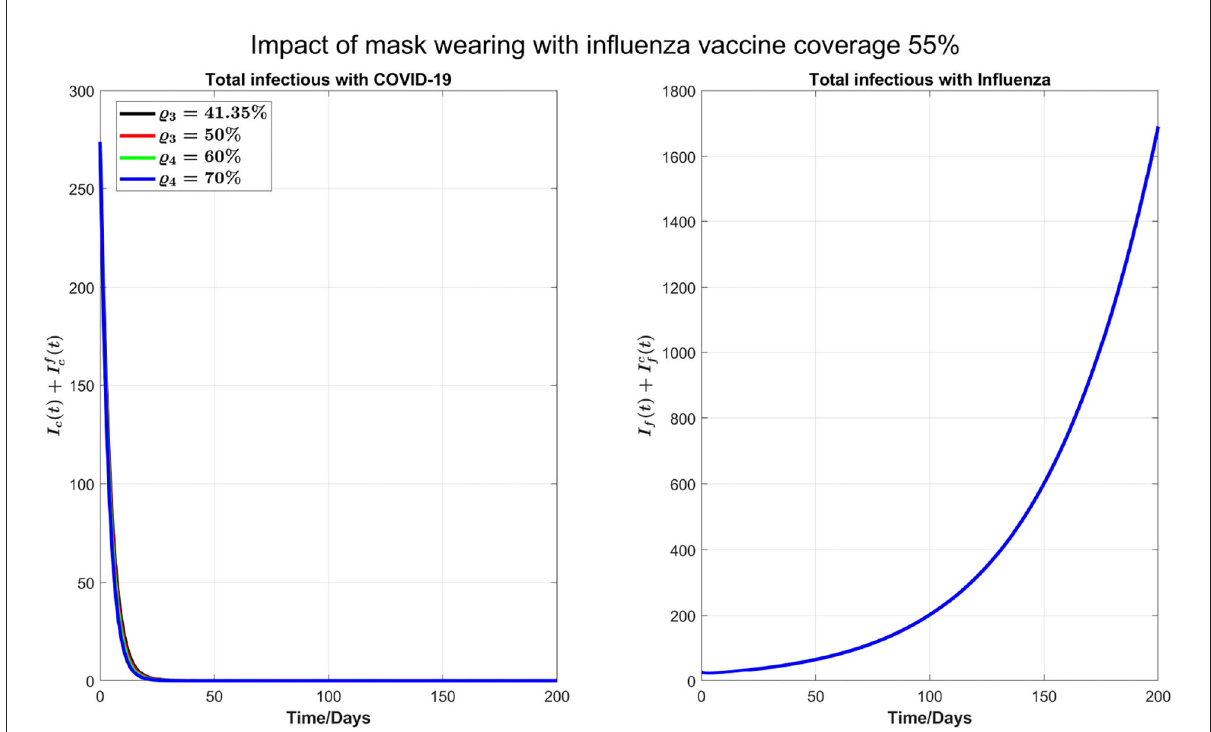
FIGURE8 Impact of 20% mask-wearing with an increasing coverage of COVID-19 booster (third dose) and 55% influenza vaccine coverage on COVID-19 and influenza